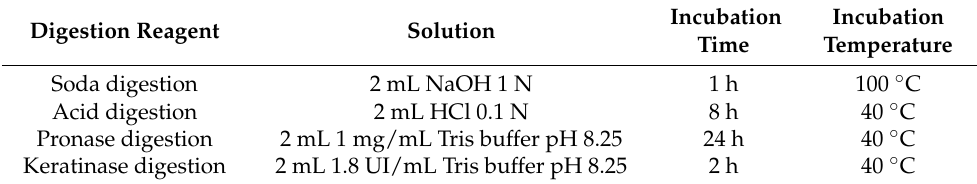
Table 1. Test of digestions, procedure